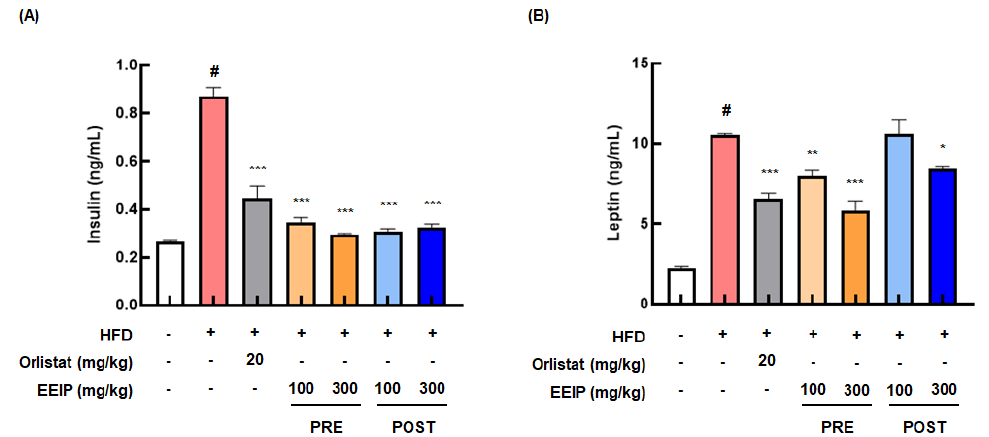
Figure 5. Effect of EEIP on the plasma level of insulin and leptin in HFD−fed obese mice. EEIP mod-